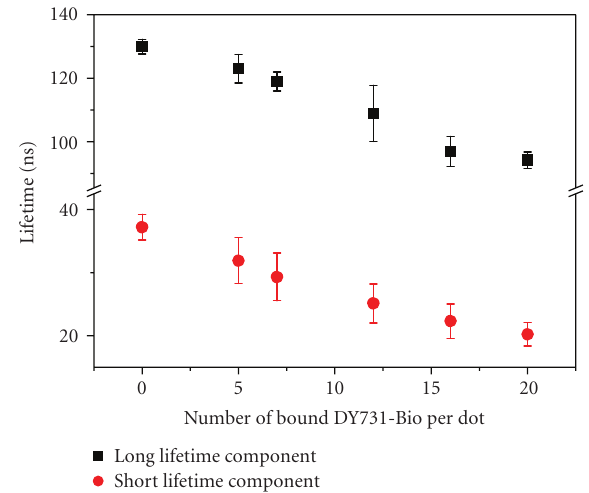
Figure 6: Plot of the lifetime components derived from the biexpo- nential fit of Qdot705-STV fluorescence decay versus the number of conjugated DY731-Bio per Qdot705-STV.